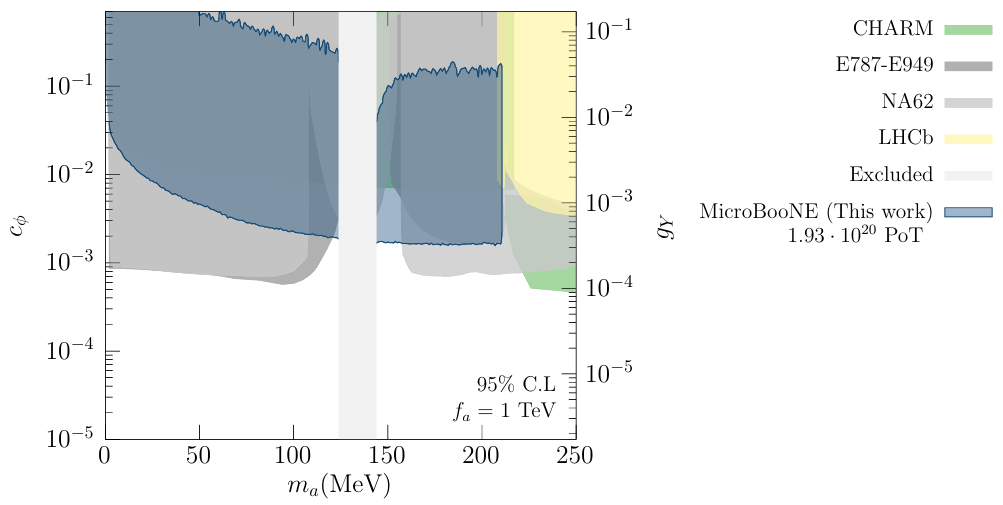
Figure 2 . MicroBooNE bounds (at 95% C.L.) on c φ , for f a = 1 TeV and setting c W = c B = 0 . These are obtained from a reanalysis of the data in ref. [29], which used 1 . 93 × 10 20 Protons on Target (PoT). For comparison we also show the constraints from the NA62 experiment [21, 40], E787 & E949 [20], CHARM [22, 36] and LHCb [8, 18, 19]. The shaded vertical band is excluded due